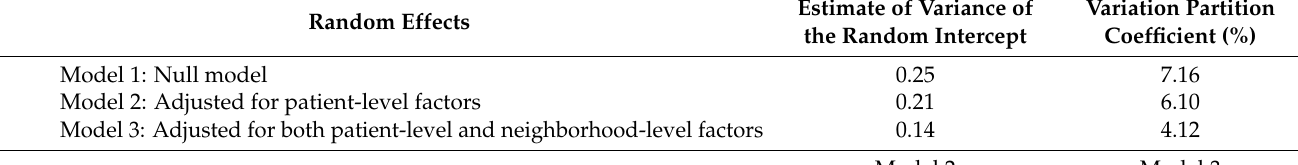
Table 4. Random intercept multi-level logistic regressions on patient portal use adults with multimor- bidity, linked electronic health records with zip code-level American Community Survey,